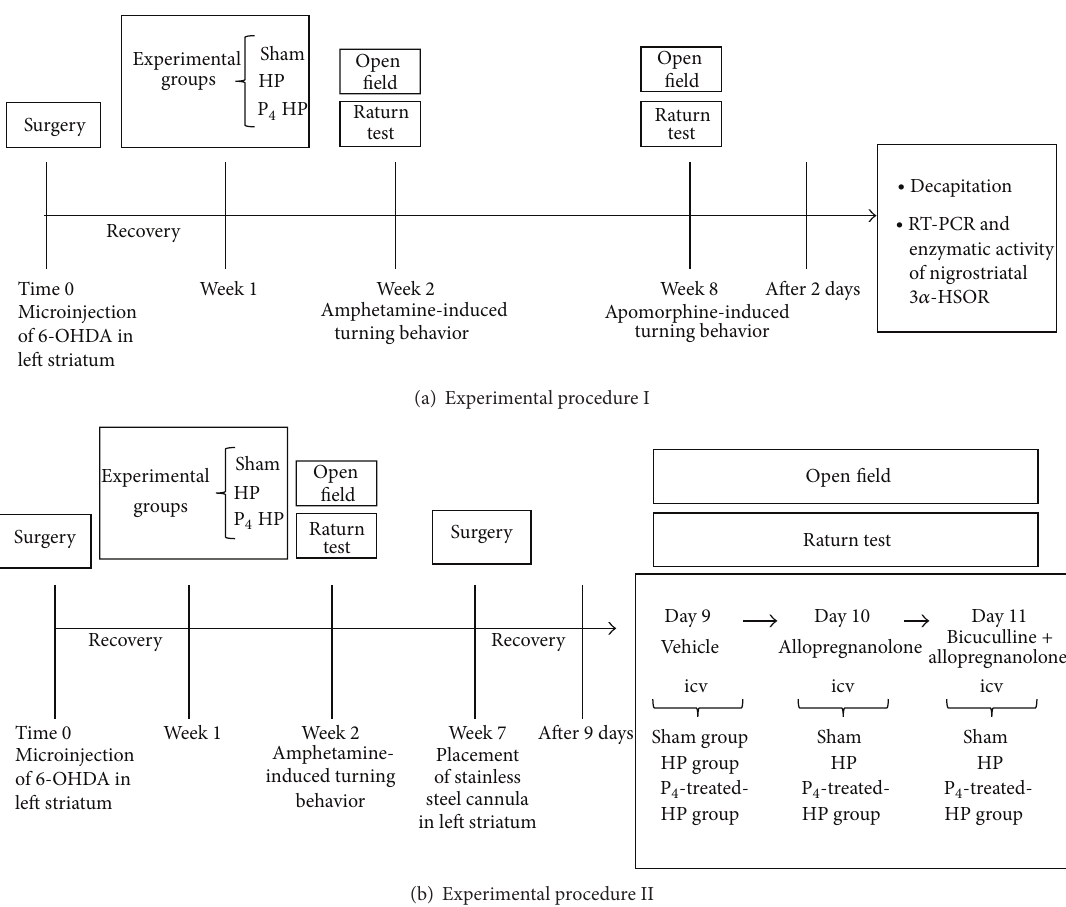
Figure 2: (a) Experimental procedure I: performed to evaluate the effects of progesterone on turning behavior and effects on nigrostriatal expression and enzymatic activity of 3 𝛼 -HSOR of hemiparkinsonian rats. (b) Experimental procedure II: performed to study the effects of allopregnanolone on turning behavior of hemiparkinsonian rats. HP group (hemiparkinsonian group), P 4 -treated HP group (progesterone- treated hemiparkinsonian group). Time 0: